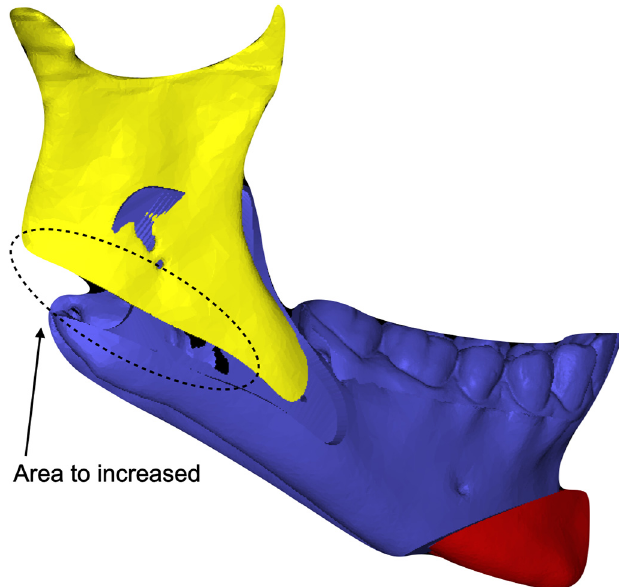
Fig. 3. Area to increase ramus, and projection of angle mandible. *Digital Images have been taken in NemoStudio, NemoFAB, Version 2019. Table I. Indications and limitations of modi fi ed bilateral sagittal split osteotomy (BSSOM).